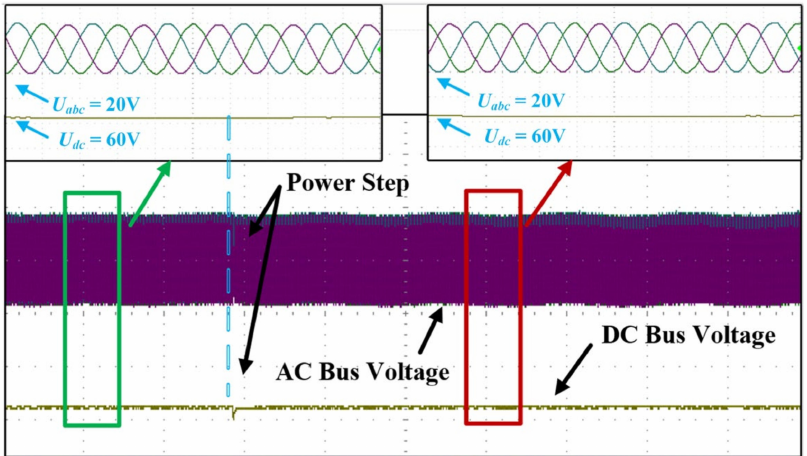
Figure 20. AC and DC bus voltage waveforms of microgrids when the battery is in charging mode (CPL power varied from 20 W to 45 W).